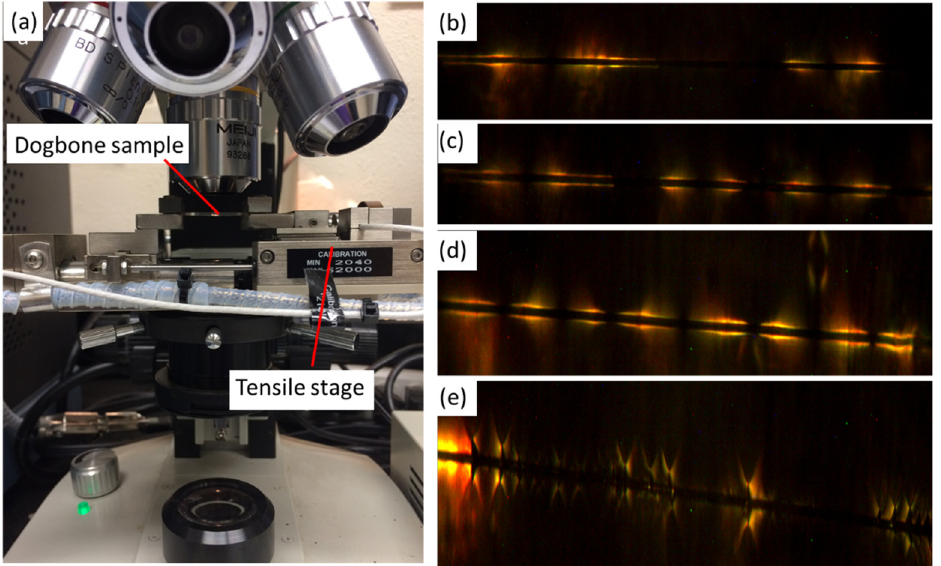
Figure 5. ( a ) Setting up of single-fiber fragmentation test, crack pattern of bare carbon fiber and carbon fiber with ZnO nanowires under different growth concentrations: ( b ) bare carbon fiber, ( c ) 25 mmol/L, ( d ) 50 mmol/L, and ( e ) 100 mmol/L. ( c ) 25 mmol/L, ( d ) 50 mmol/L, and ( e ) 100